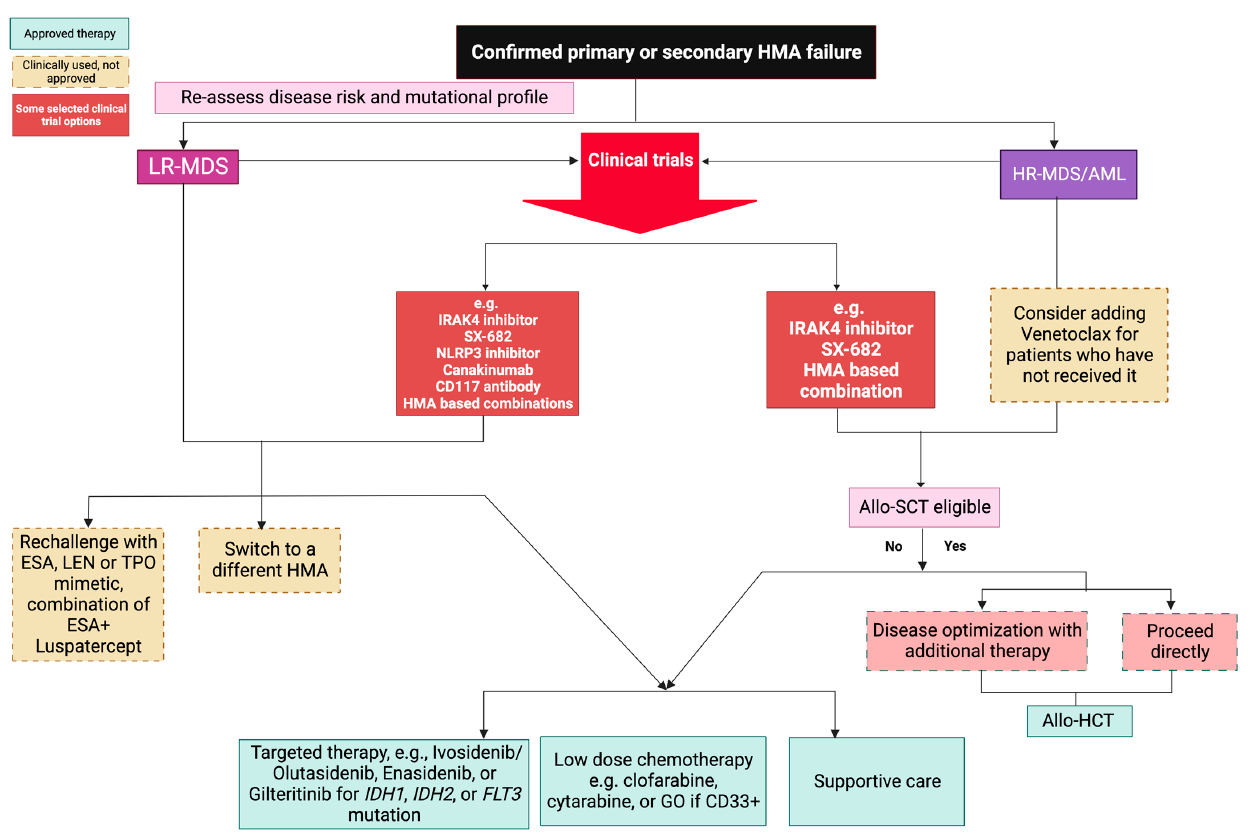
Figure 1. Post hypomethylating agent therapy options for LR and HR-MDS/AML. Clinical trial options are encouraged.